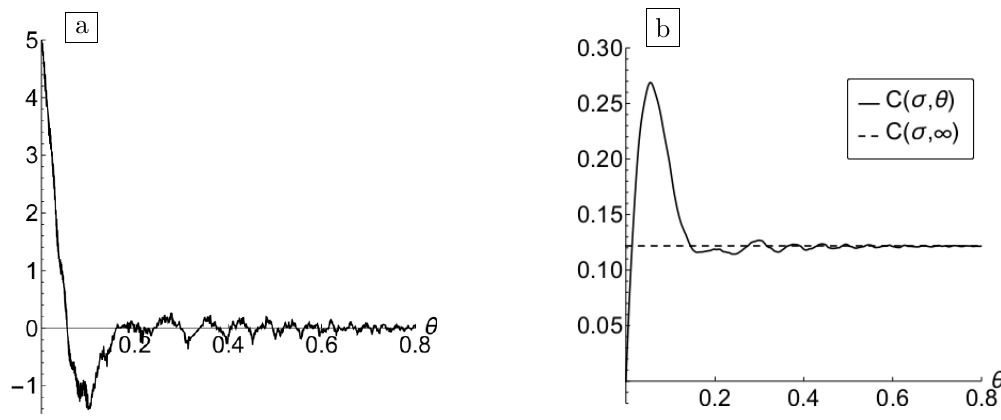
Figure 5 . a) Example integrand to be integrated over to calculate @ I (cid:0) =@(cid:27) . b) The corresponding cumulative distribution